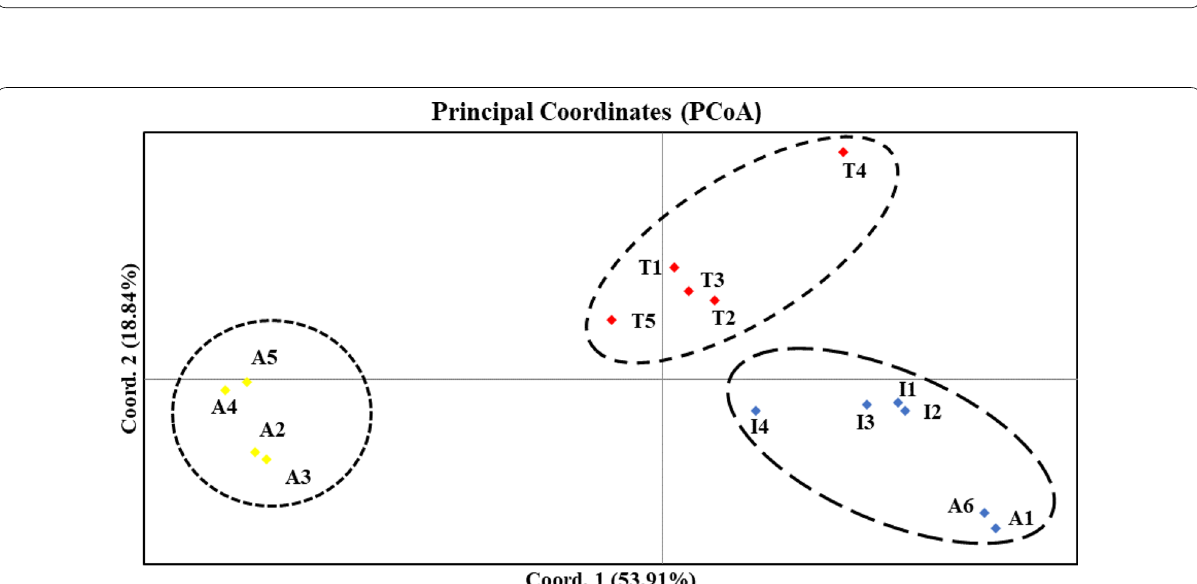
Fig. 2 Genetic structuring of the15 tropical N. nucifera populations obtained from the STRU CTU RE analysis, K of K against delta K (shown on the right)